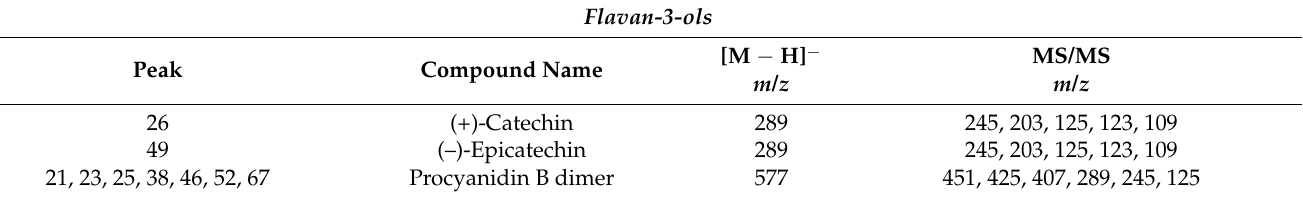
Table 1. Identified polyphenols from European beech wood extracts—chromatographic and mass spectrometric data. * Detected as [M − H + HCOOH] −